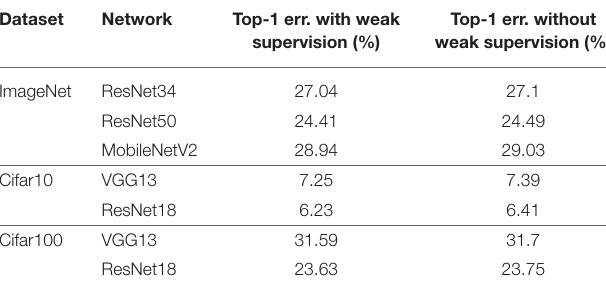
TABLE 7 | Accuracy and runtime benefits of LoCal+SGD on U-Net. Training